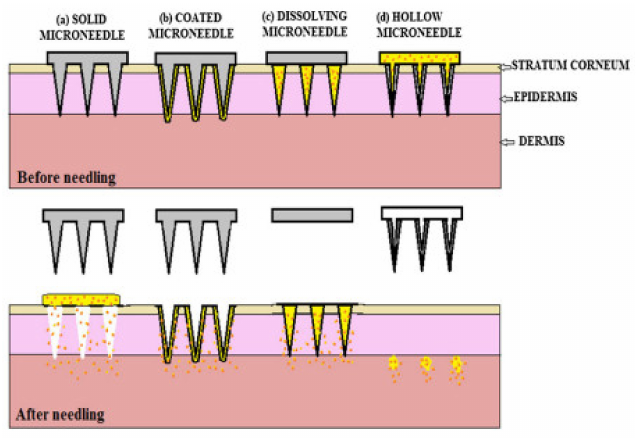
Figure 1. Types of MNs [14]. (Adapted from Ref.